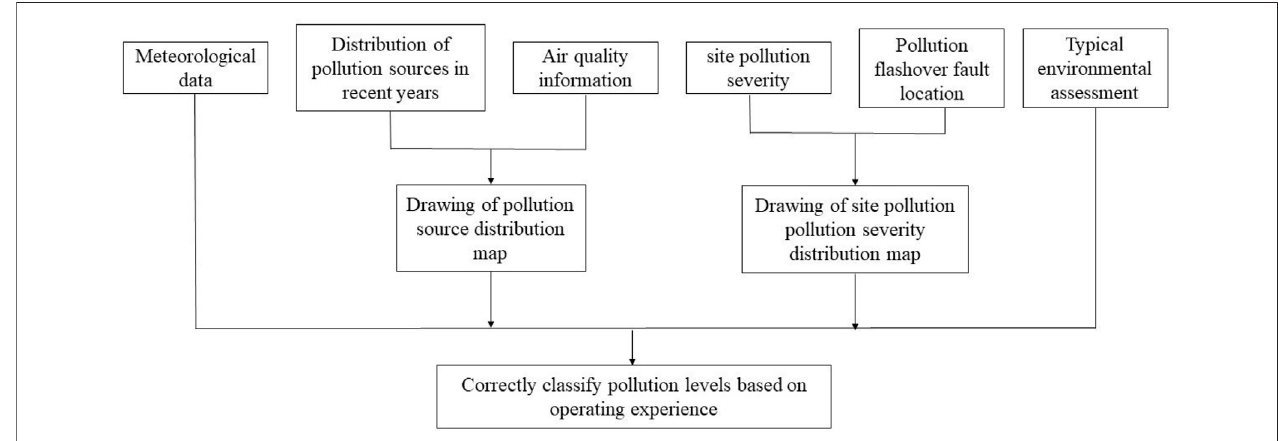
FIGURE 3 | Procedure of manually mapping pollution distribution.